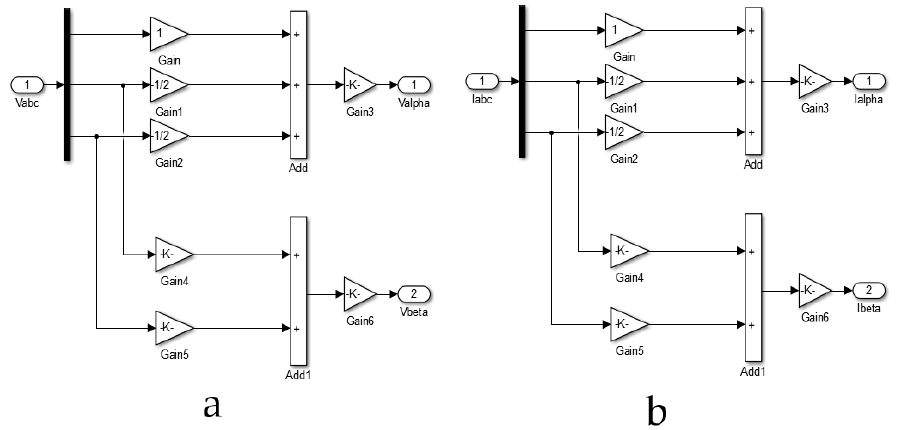
Figure 10. Simulink model of the Clarke transformation ( a ) voltage transformation; ( b ) current transformations.